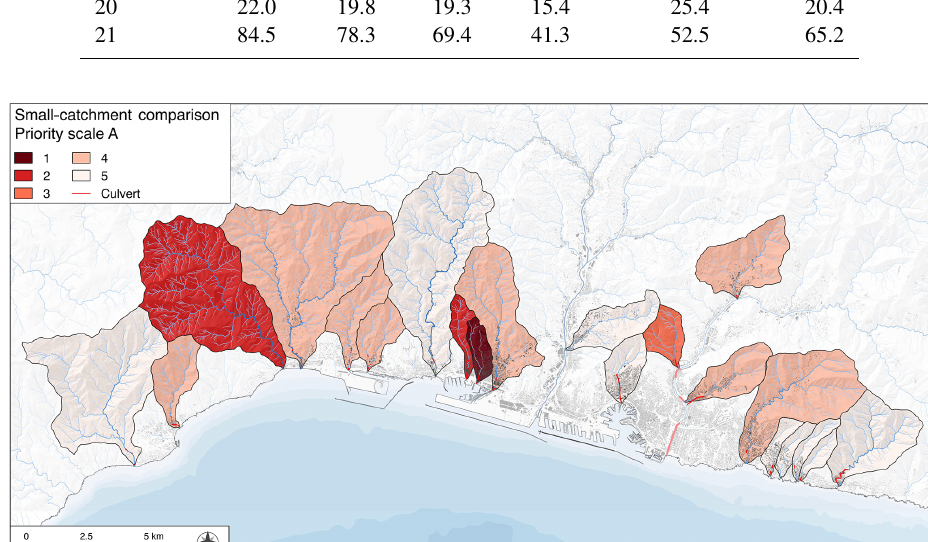
both natural features of the catchments and the